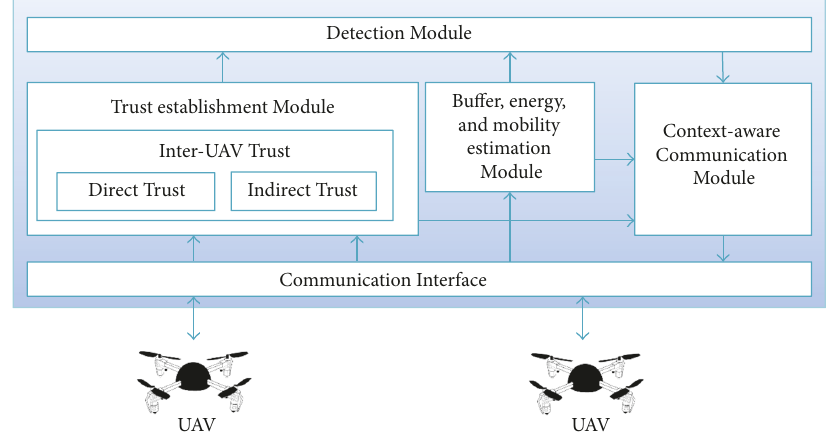
Figure 3: Proposed modular architecture.